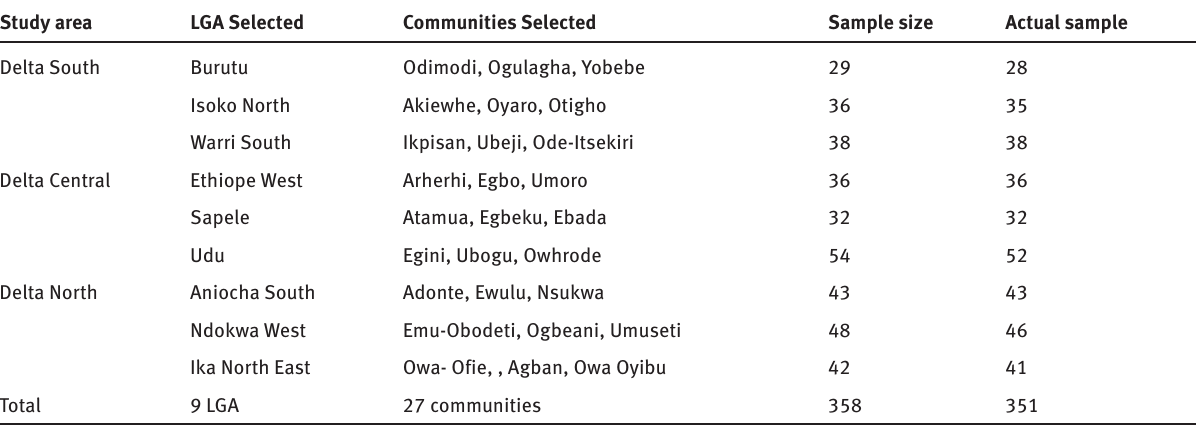
Table 1: Sample identified to work with